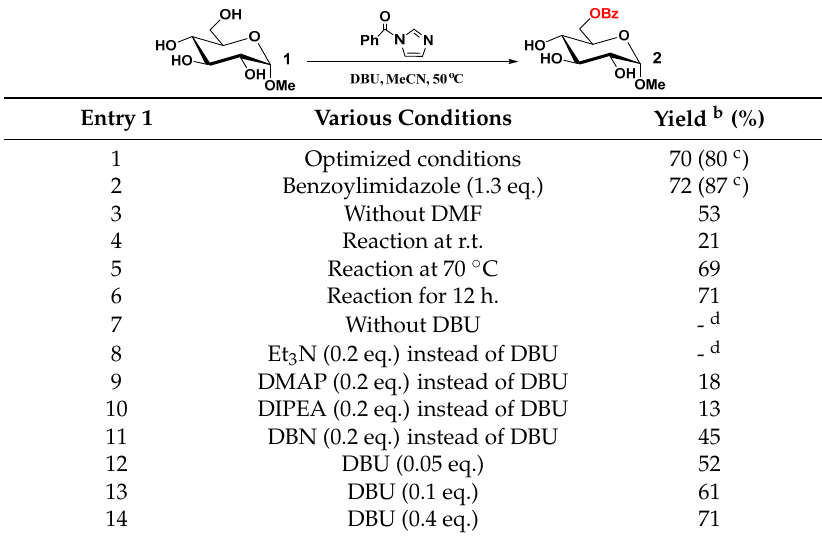
Molecules 2016 , 21 , x 3 of 9 8). Low yields were obtained with DMAP, DIPEA or DBN instead of DBU (Entries 9, 10 and 11).